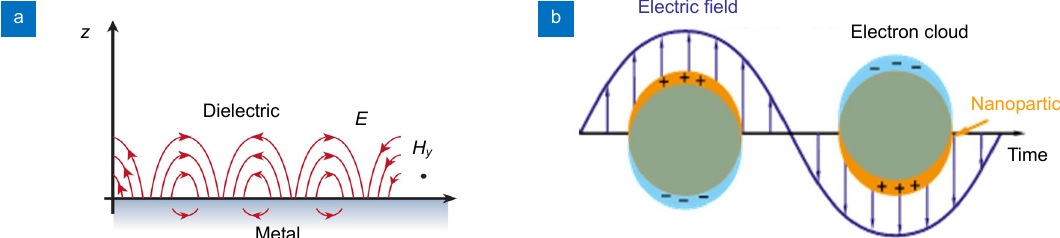
Fig. 1 | ( a ) Surface plasmon polariton at single interface. ( b ) Localized surface plasma resonance for subwavelength metal nanoparticles. Figures reproduced from: (a) ref. 26 , Nature Publishing Group; (b) ref. 27 , Springer International Publishing AG.